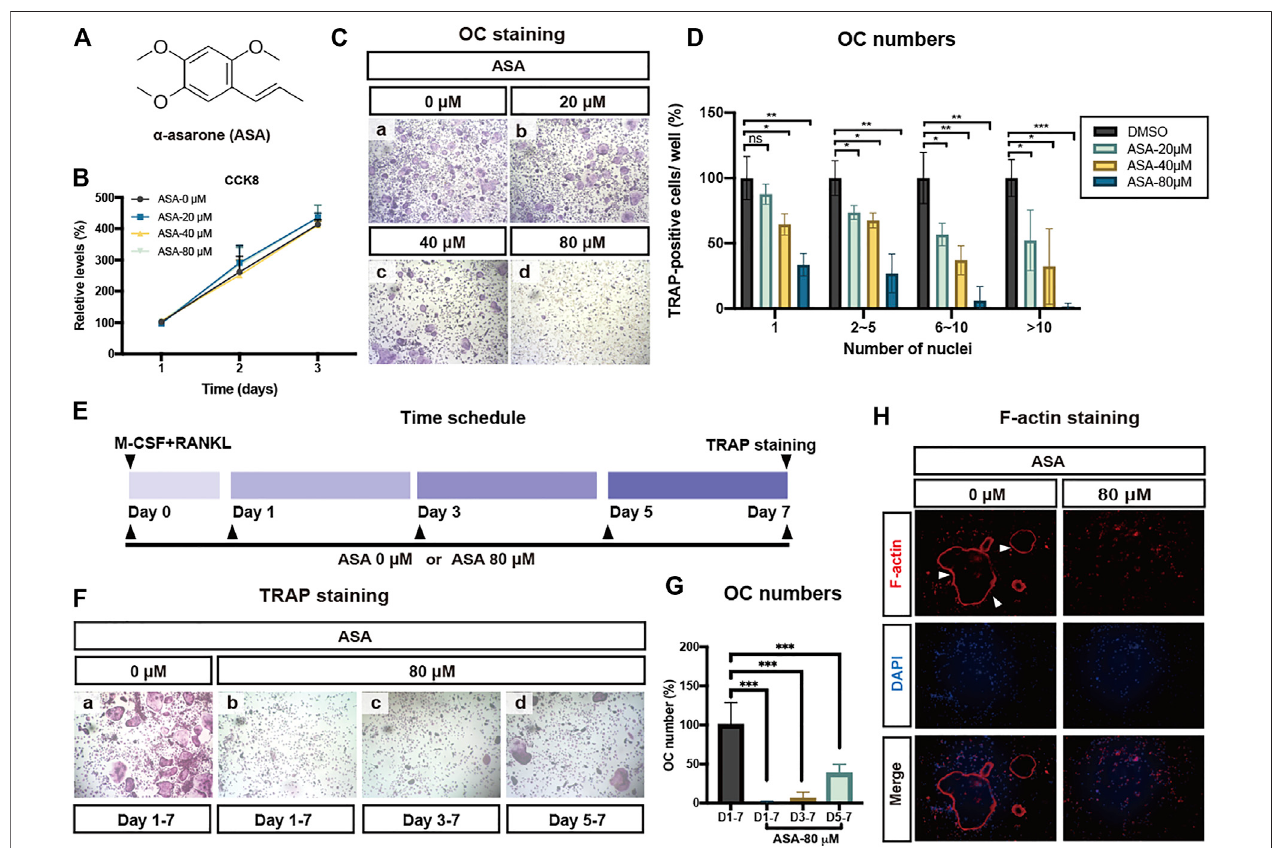
FIGURE1| ASA inhibited OCs differentiation and actin structure formationwithoutany cytotoxicity. (A) ThechemicalstructureofASA. (B) Effect ofASAon BMMs proliferation. Increasing doses of ASA (0.1% DMSO as a control) were incubated with BMMs which was sustained for proliferation by M-CSF for indicated days. Cell proliferation were determined by CCK8 assay. (C) Effect of ASA on OCs activation and differentiation. Indicated concentrations of ASA (0.1% DMSO as a control) were incubated with BMMs which were induced to differentiate into OCs by M-CSF and RANKL and then TRAP staining was applied to identify TRAP-positive multinucleated cells. (D) The numbers of TRAP-positive cells of different treatments as shown in (C) were calculated and presented graphically. The number of mononuclear, multinuclear (2 – 5 nuclei; 5-10 nuclei) and giant cells ( > 10 nuclei) was counted. The average number of TRAP-positive cells in each division in the control groupwasde fi nedas100%.Theaveragenumbersforthecontrolgroupwere1207formononuclearcells,152formultinuclearcells(2 – 5nuclei),27formultinuclearcells (5-10 nuclei) and 21.7 for giant cells ( > 10 nuclei). * p < 0.05, ** p < 0.01, *** p < 0.001vs control. (E) Time schedule of experiments that determine the stage at which ASA blocked osteoclastogenesis (F) ASA inhibited RANKL-stimulated osteoclastogenesis at all stages, especially at early stage. (G) The numbers of TRAP-positive multinucleated cells of different treatments as shown in (F) were calculated and presented graphically. *** p < 0.001vs control. (H) BMMs were incubated with/without 80 μ MASA(0.1%DMSOasacontrol)for5-7 daysiFluorTM555-Phalloidin(red)andDAPI(blue)stainingwasperformed.CellswereobservedandimagedusingaZEISS fl uorescence